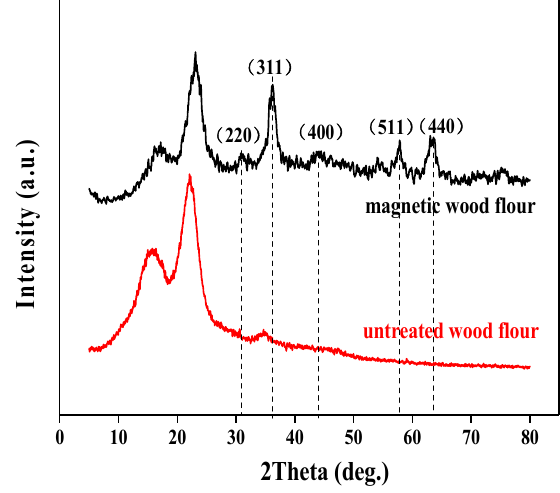
Figure 2. X-ray diffraction (XRD) patterns of the pure flour and the magnetic wood flour.